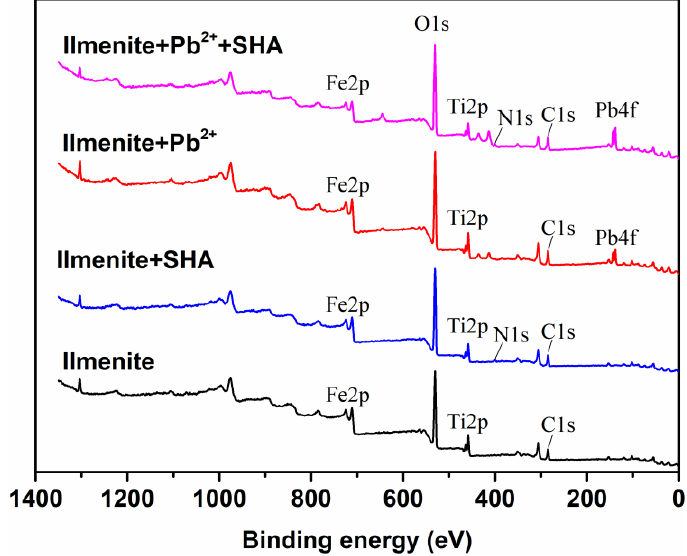
Figure 8. XPS survey spectra of ilmenite, before and after Pb 2+ and SHA treatment. Table 2. Relative atomic concentrations of elements on ilmenite surfaces.